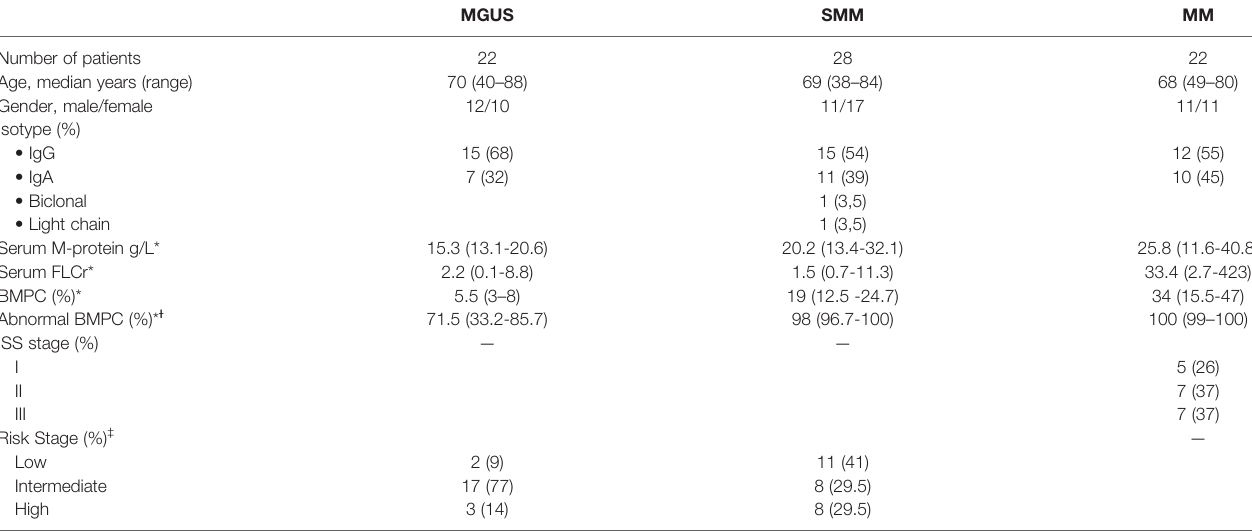
TABLE 1 | Patient